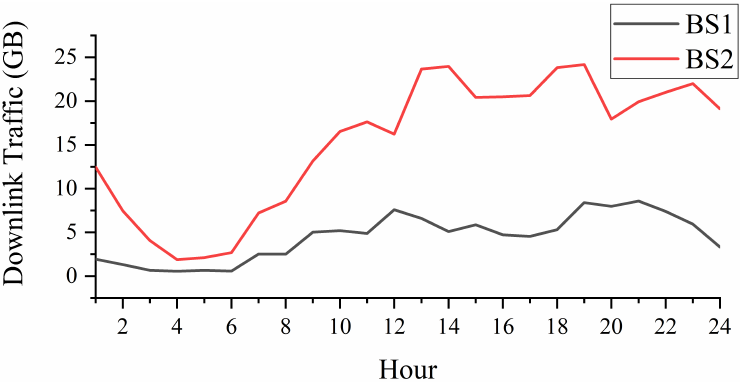
Figure 2. Downlink traffic of two BSs.